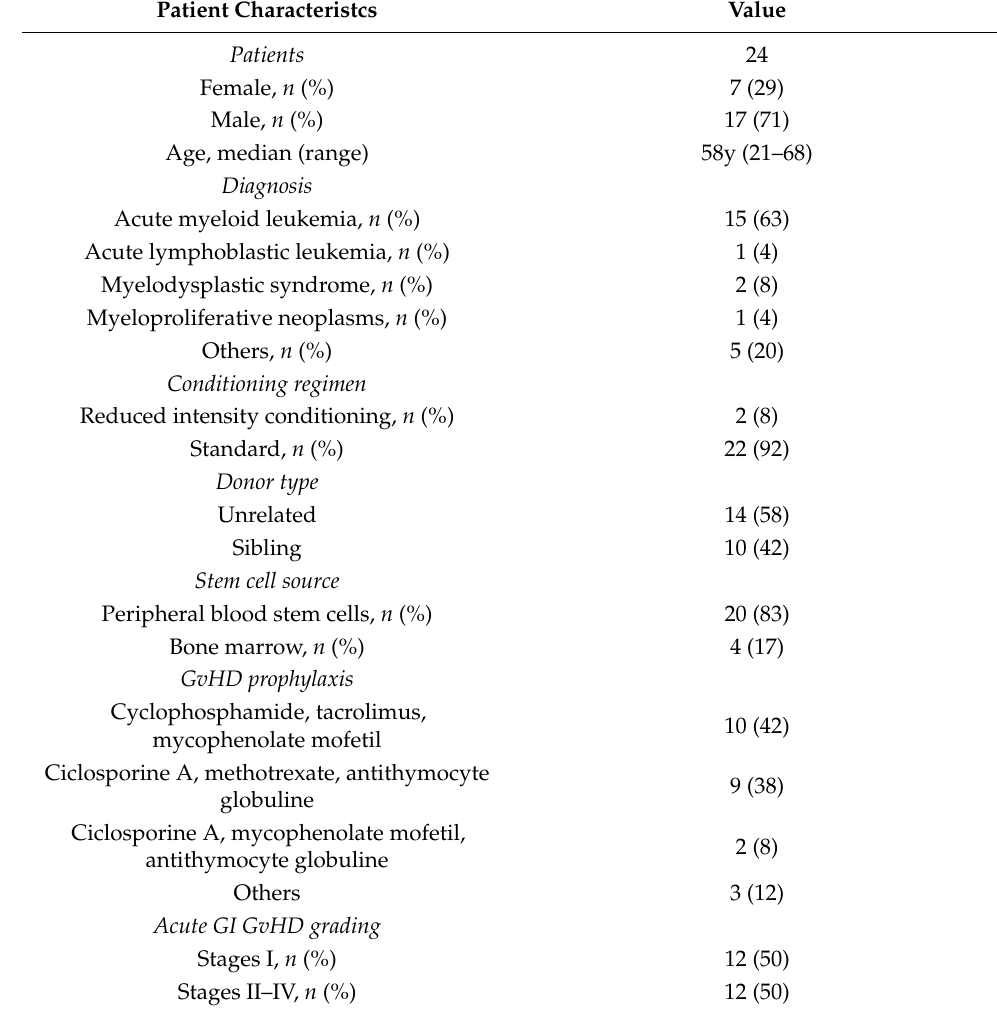
Table 1. Patient